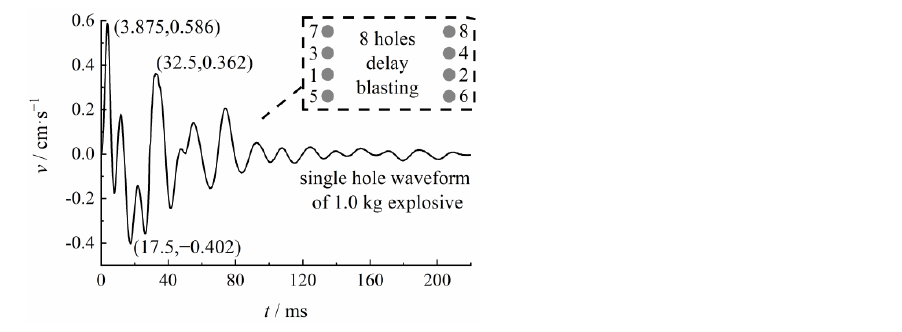
Figure 8. Hole layout of the cut blasting test and a single-hole wave from the single-shot test.